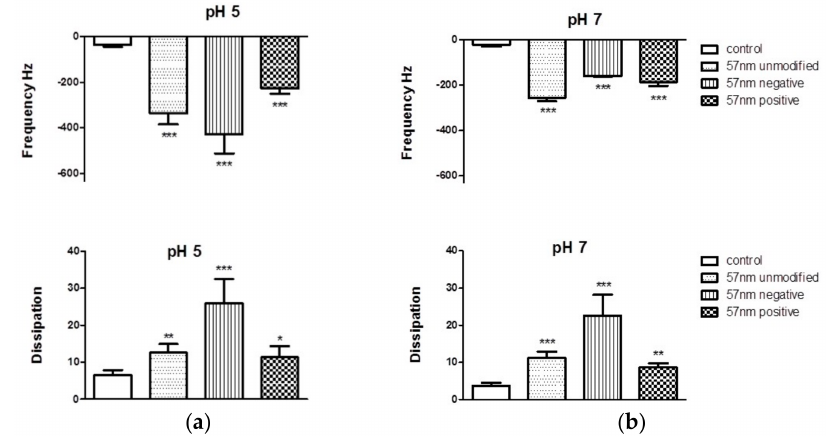
Figure 3. Statistical analysis of the interaction of polystyrene NPs with the mucin layer at ( a ) pH 5 and ( b ) pH 7 measured by quartz crystal microbalance with dissipation technology. Data are presented as mean ± SD ( n = 3). One-way ANOVA followed by Tukey–Kramer multiple comparison post-test. * p < 0.05; ** p < 0.01 and *** p < 0.001 vs.